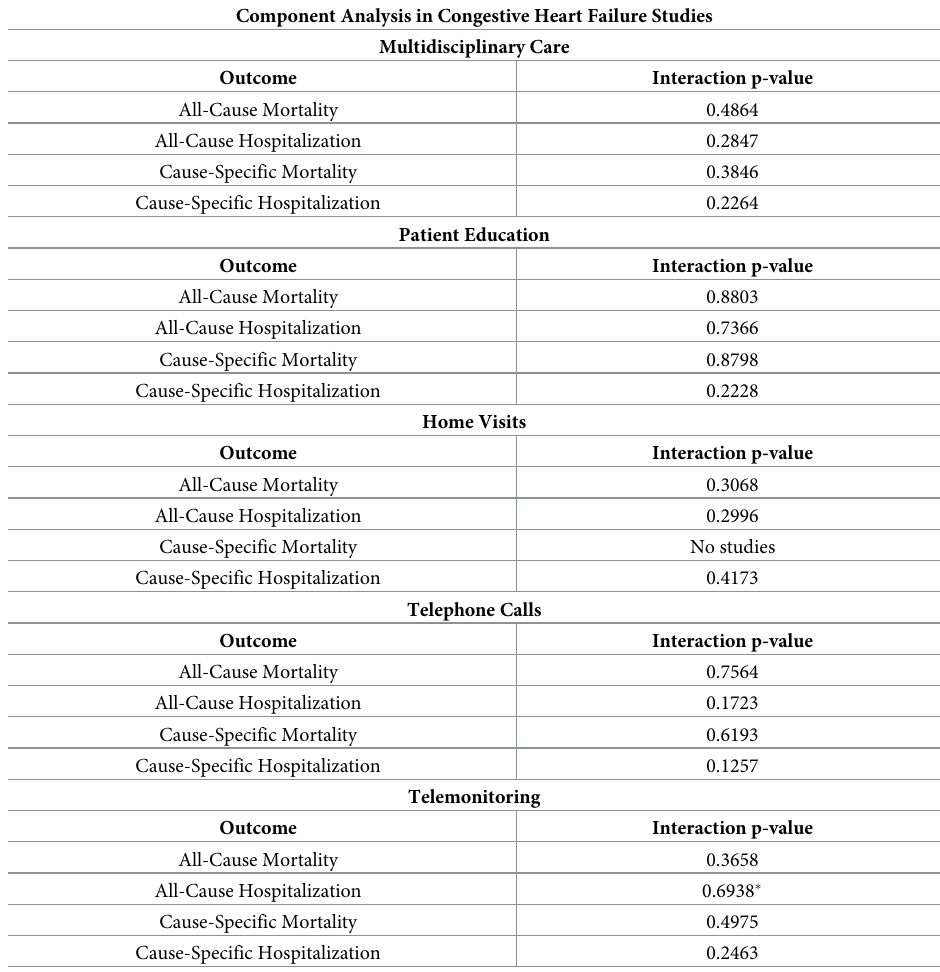
Table 3. Component analysis in heart failure